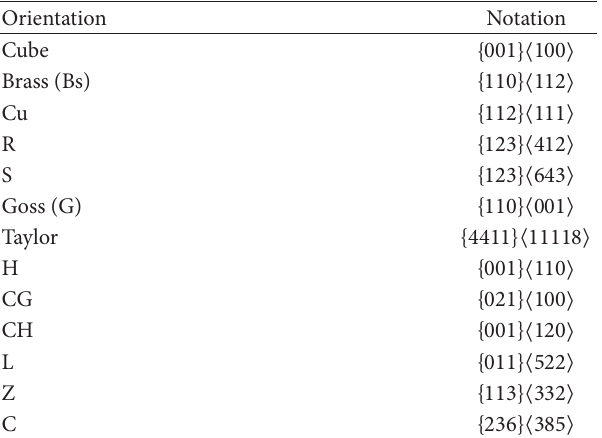
Table 1: Representation of ideal texture